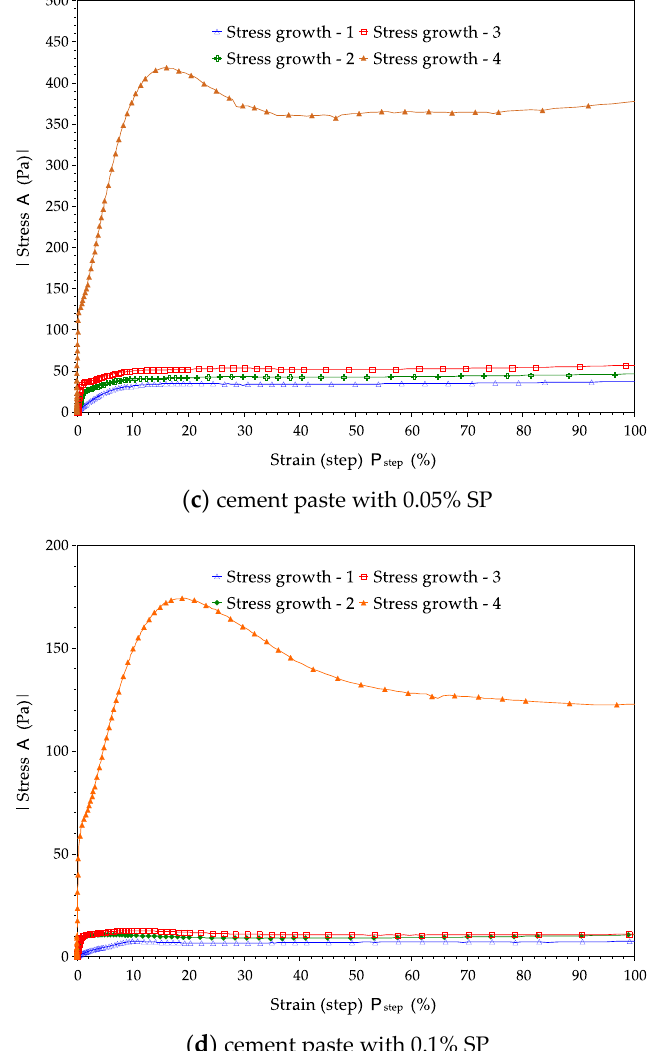
Figure A1. Example of the yield stress measurements of calcite ( a ), cement paste ( b ), cement paste with 0.05% SP ( c ), and cement paste with 0.1% SP ( d ) during Procedure 2.